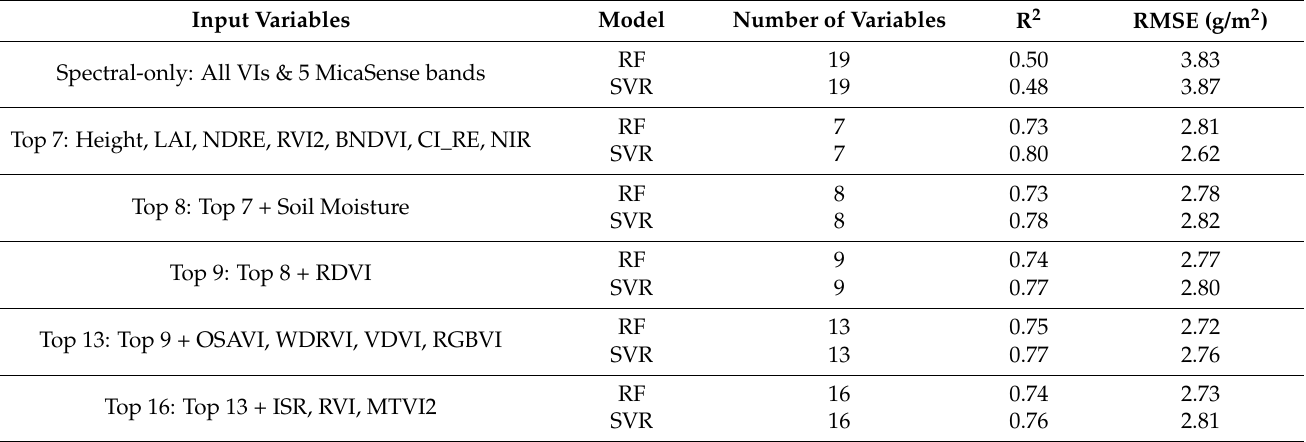
Table 10. Statistics for the validation of the canopy nitrogen model with 12, 20, and 27 May MicaSense data and different combinations of variables ( n = 39) 1